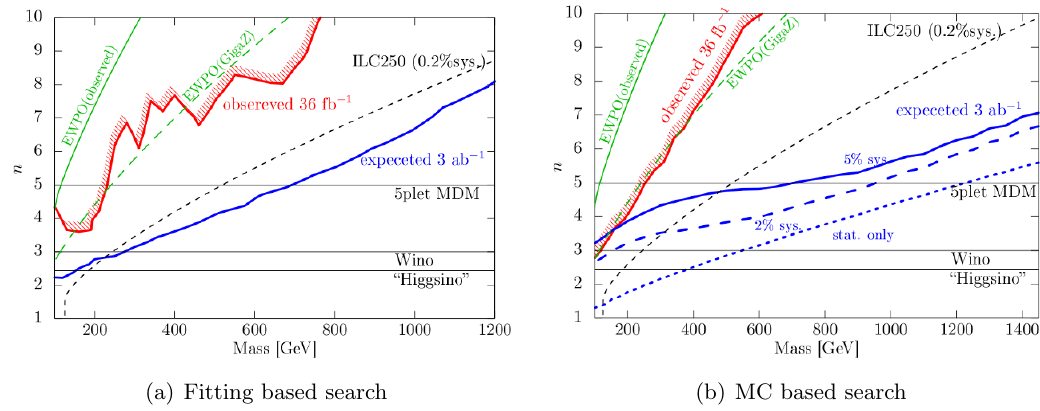
Figure 5 . The constraint on a Majorana fermionic EWIMP at 95% con(cid:12)dence level obtained by the (cid:12)tting based analysis (left panel) and the MC based analysis (right panel) on the plane of the EWIMP mass and the SU(2) L quantum number ‘n’. The present constraint from 36 fb (cid:0) 1 data at the 13 TeV running is shown as a thick red line (associated with a small hatch) in both panels, while the future expected constraint from 3 ab (cid:0) 1 data at the 14 TeV running is shown as a blue solid line in the left panel and blue solid, dashed and dotted lines in the right panel, depending on the systematic uncertainty associated with the SM background estimation. Regions above the lines are (expected to be) excluded. Theoretical predictions from the well-motivated EWIMP candidates; wino, fermionic minimal dark matter (5plet MDM) and Higgsino, are also shown as horizontal (thin solid) black lines. On the other hand, the green solid line represents the constraint from the electroweak precision measurements, while the green dashed line is the future prospect assuming the electroweak precision measurements at the Giga-Z option. The future expected constraint from fermion pair productions at the international linear collider (ILC) with the 250 GeV running is shown as a black dotted